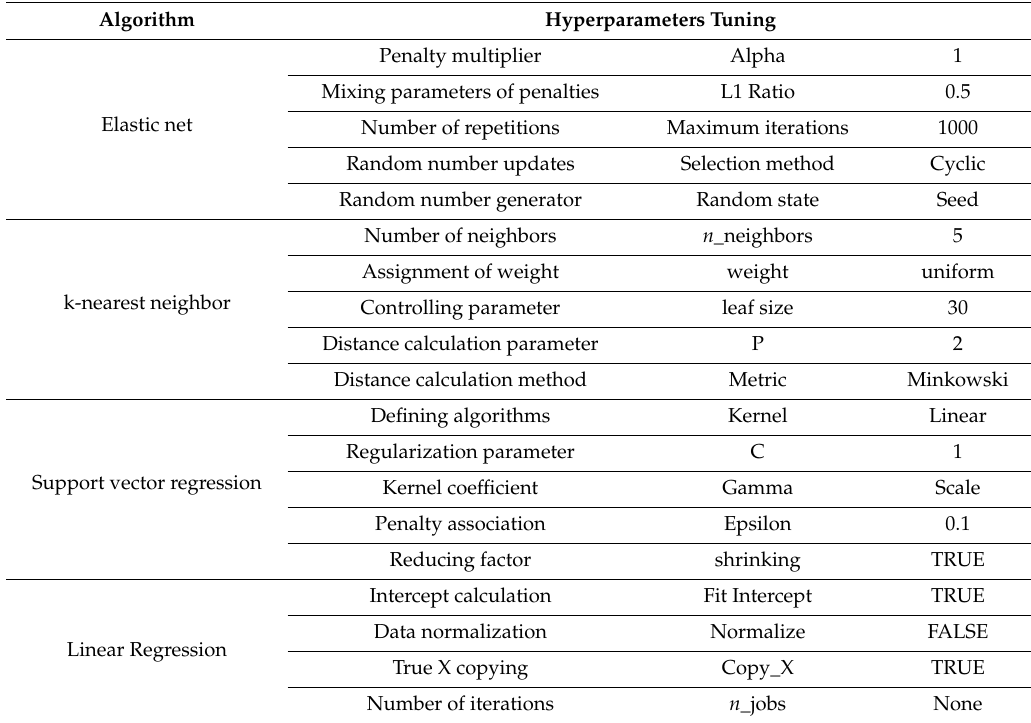
Table 2. Hyperparameter tuning of machine learning